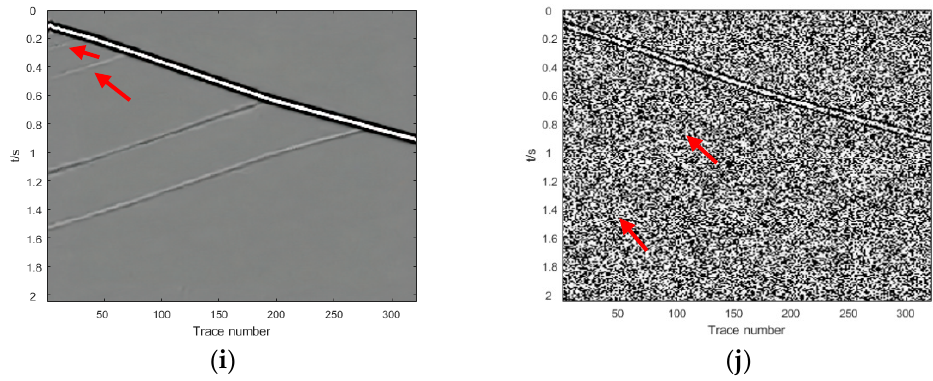
Figure 6. Denoising results of VSP data. The red arrows on the left ( c , e , g , i ) and right sides ( d , f , h , j ) of the figure plate respectively mark the weak reflection waves and the parts of the signal leakage. ( a ) Clean data; ( b ) Noisy data; ( c ) Denoised image through the pre-trained model; ( d ) The difference profiles between noisy data ( b ) and pre-denoised data ( c ); ( e ) Denoised data through the proposed method; ( f ) The difference profiles between noisy data ( b ) and denoised data ( d ); ( g ) Denoised data through the DnCNN; ( h ) The difference profiles between noisy data ( b ) and denoised data ( g ); ( i ) Denoised data through the U-net; ( j ) The difference profiles between noisy data ( b ) and denoised data ( i ). Table 3. Quantitative comparison of the first synthetic example.